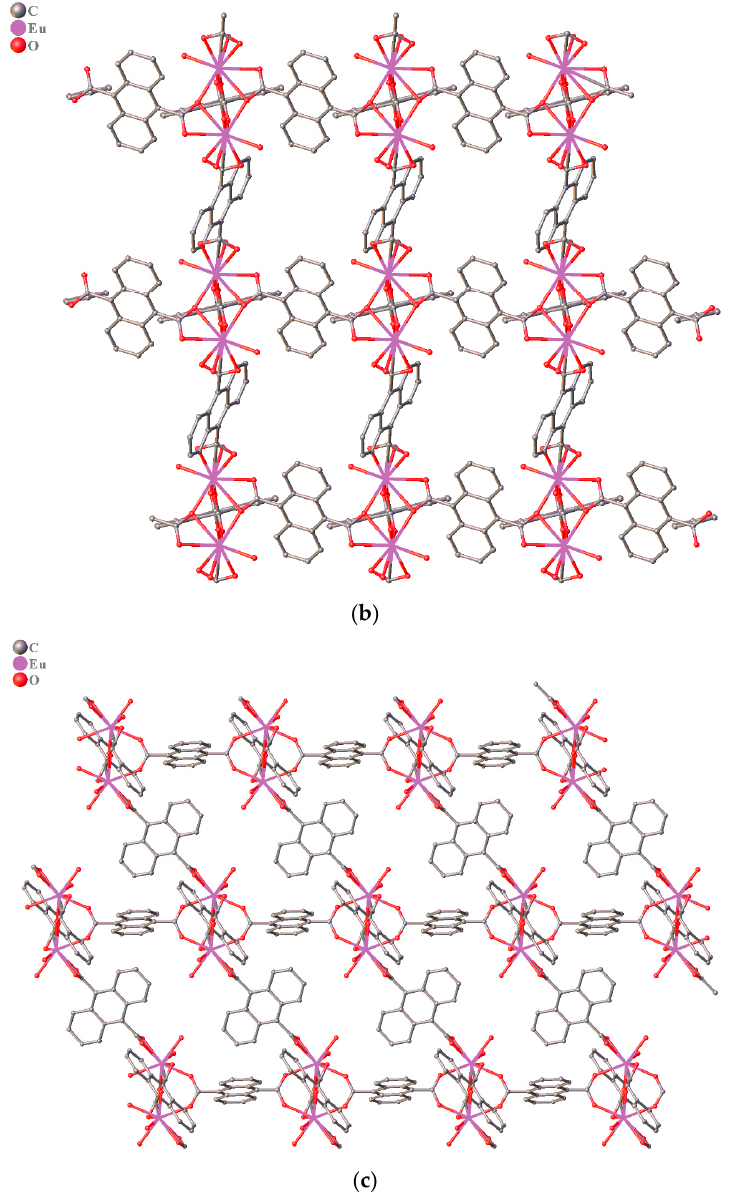
Figure 1. ( a ) Coordination environment of Eu1 atoms in 1. ( b ) Interconnectivity of bis -chelating chains along the (100) direction. ( c ) Interconnectivity of bis -bridging and bis -chelating chains along the (010) direction (Coordinated solvent and hydrogen atoms are omitted for clarity).